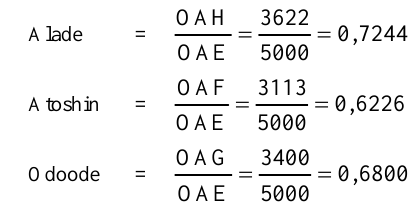
Figure 2: Lorenz curves for marketers in cocoa industry in Alade, Atoshin, and Odoode in Idanre, Ondo State, Nigeria. 2000/2001 Season Source: Akinola,